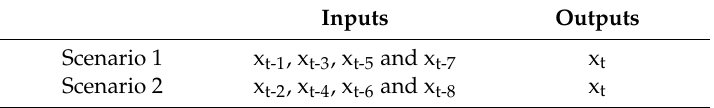
Table 1. Two proposed scenarios for time-series prediction of COVID-19 in